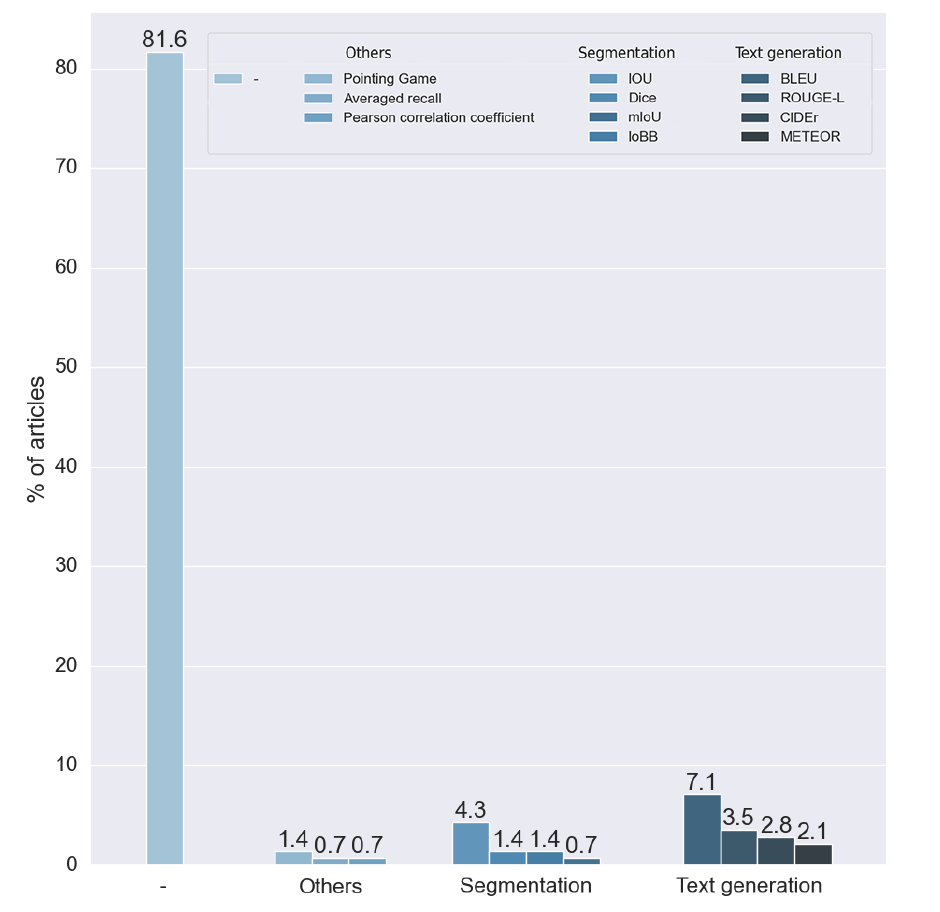
Figure 20. Metrics used for the evaluation results of RQ8. Vertical axis indicates the percentage of articles for each